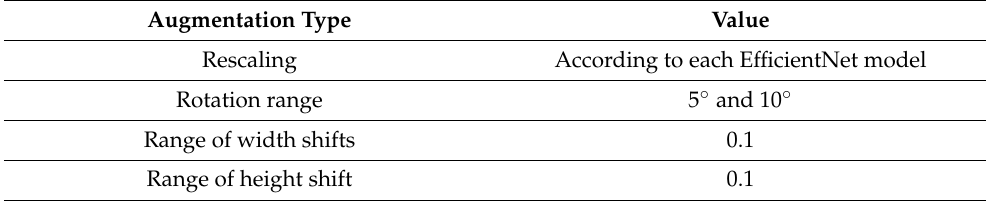
Table 3. The settings of the data augmentation applied to the stain-normalized X-ray images. Augmentation Type Value Rescaling According to each EfficientNet model Rotation range 5 ◦ and 10 ◦ Range of width shifts 0.1 Range of height shift